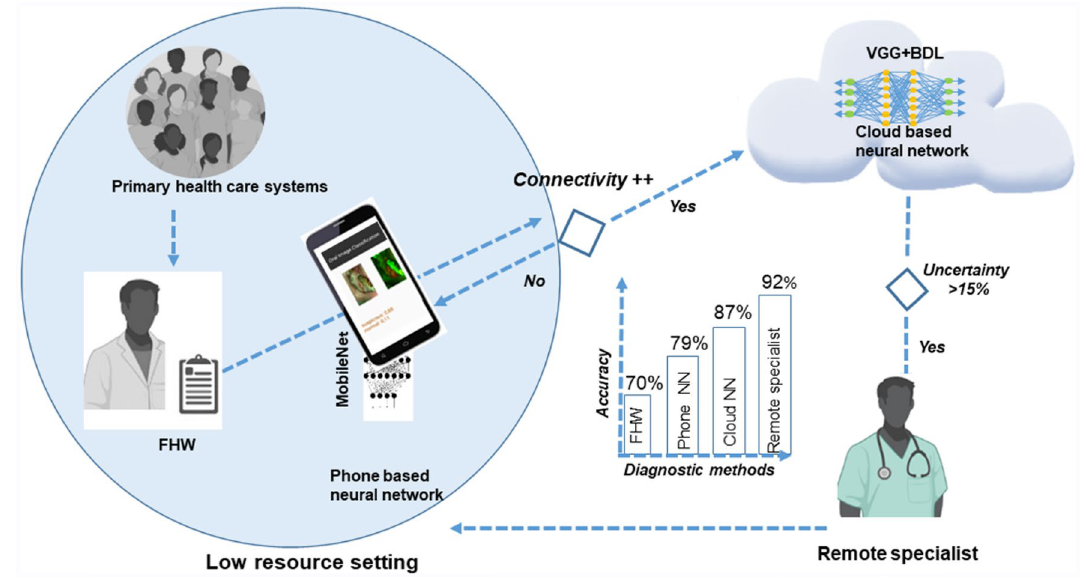
(++), a more accurate cloud-based neural network (VGG19-BDL, accuracy = 87%), should be used and difficult cases with high uncertainty value should be referred to remote specialists (accuracy = 92%) for interpretation. NN Neural Network, FHW Front-Line-Health-Workers, VGG19-BDL : VGG19 Convolution Neural Network with Bayesian prediction. Images Primary health care systems, FHW ,Remote specialist were created with “BioRender.com” (https:// biore nder. com) and Cloud based neural network with Microsoft Paint